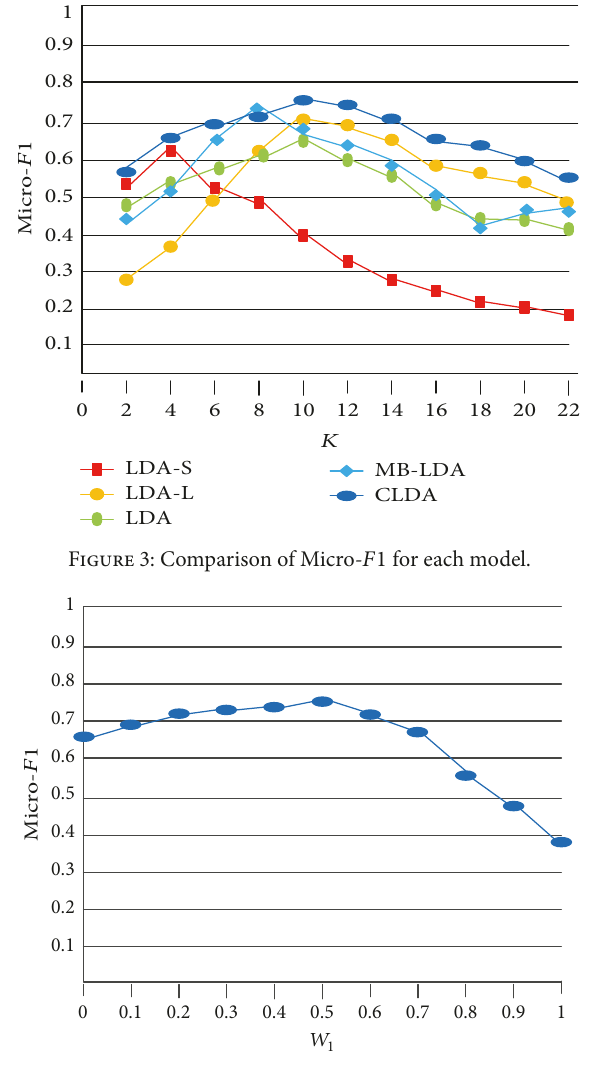
Figure 4: The importance of long text and short text in CLDA.